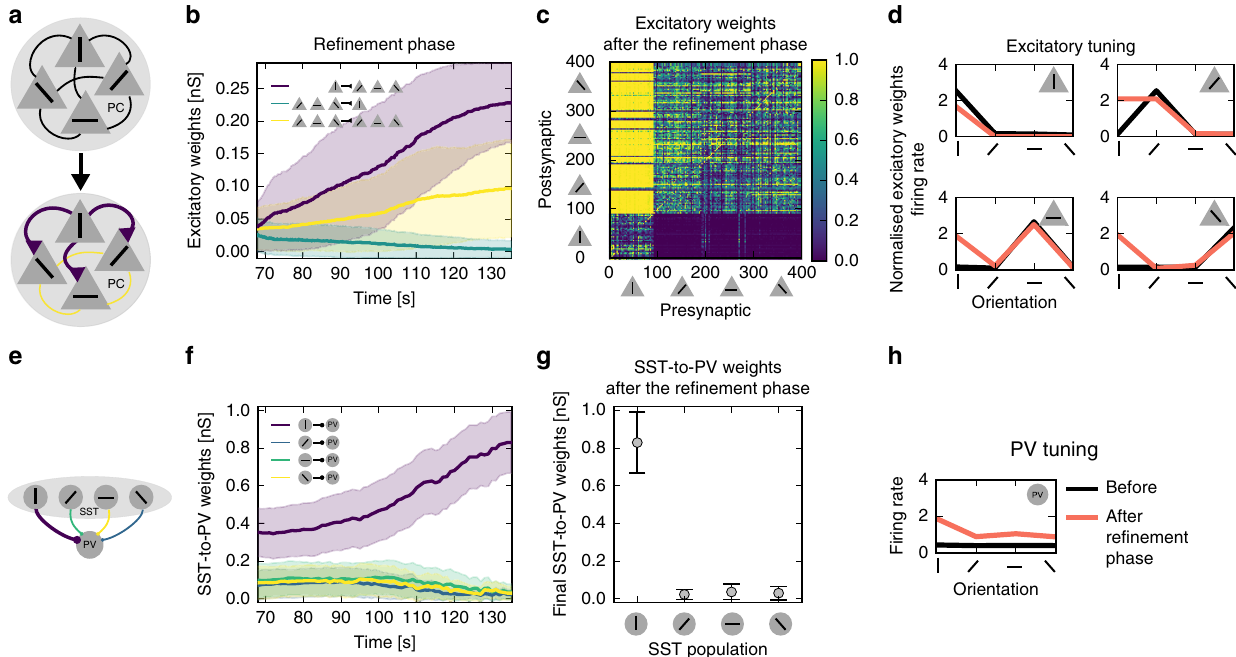
Fig. 3 Inhibitory structure guides excitatory plasticity in the absence of reward. a Illustration of changes in the excitatory structure. b Evolution of excitatory connections. Mean and s.d. of the connections from the vertically tuned PCs to PCs tuned to other orientations (purple), from PCs tuned to other orientations to the vertically tuned PC population (green), and from others to others (yellow). c Final excitatory weight matrix. Neurons 1 – 100 are tuned to the vertical bar, 100 – 200 to an angled bar, etc. d Tuning of excitatory populations before the rewarded phase (black) and at the end of the re fi nement phase (red) (number of spikes during 50 ms after stimulus onset averaged over all occurrences of that stimulus in 1 s of simulation). e Illustration of the inhibitory structure after the rewarded phase. f Evolution of the SST-to-PVs connections (mean and s.d.), grouped according to SST tuning (colours match the colours of the connections in e ). g SST-to-PV connections after the re fi nement phase, grouped by SST tuning (error bars: s.d.). h Tuning of PVs after the re fi nement